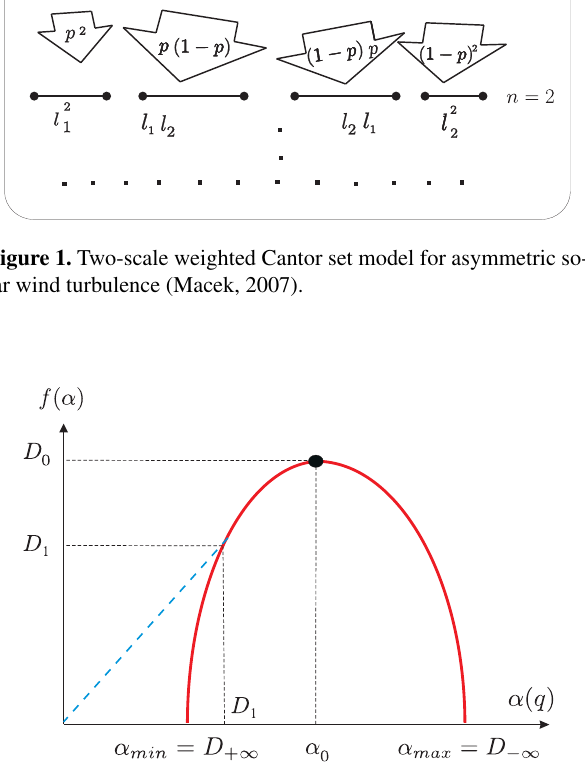
Figure 2. The singularity multifractal spectrum f (α) vs. the sin- gularity strength α with some general properties: (1) the maximum value of f (α) is D 0 ; (2) f (D 1 ) = D 1 ; and (3) the line joining the origin to the point on the f (α) curve where α = D 1 is tangent to the curve, as taken from Ott